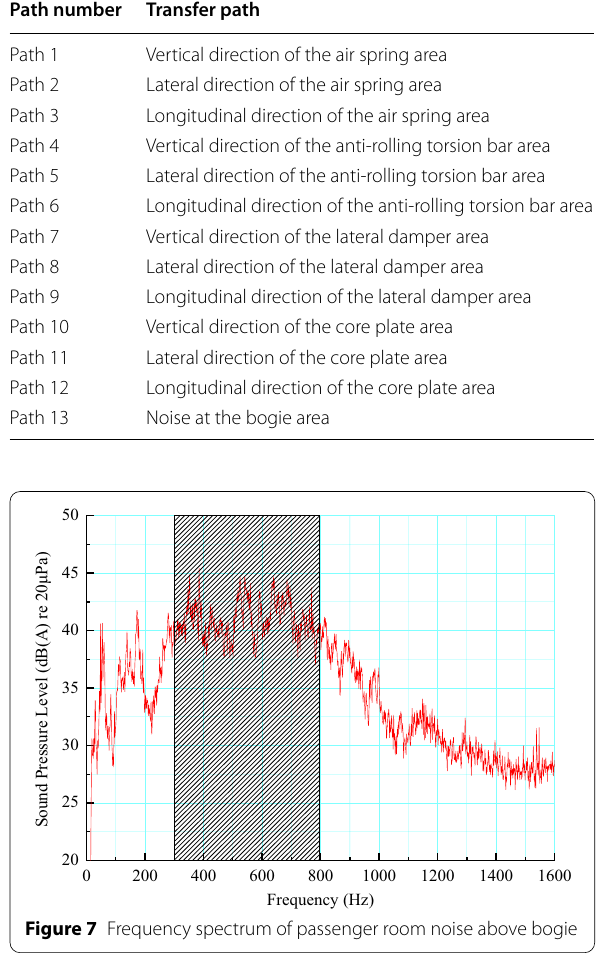
Table 3 Transfer paths Path number Transfer path